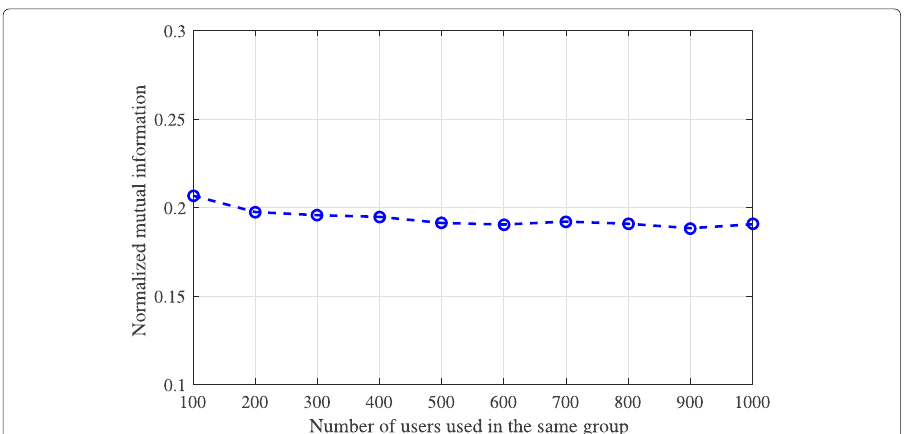
Fig. 7 Normalized mutual information between one user and the averaged quantized value of users in the same group (0.02 kW per